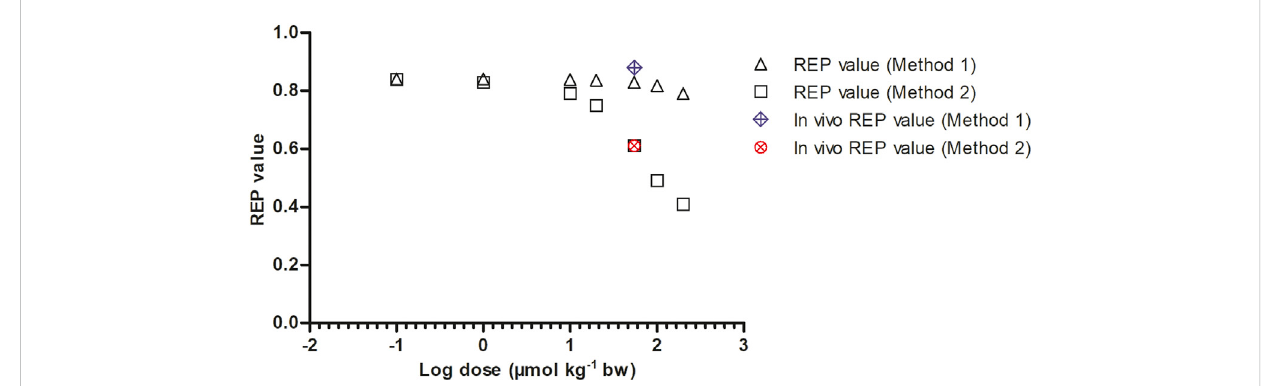
FIGURE 7 Dose dependent REP values based on Method 1 and 2 as predicted by PBK modeling-based simulations calculated with 8.20% bioavailability and fraction bioactivated of 0.20. In vivo REP values were extracted from Yang et al. (Yang et al., 2017a) as explained in Table 1.